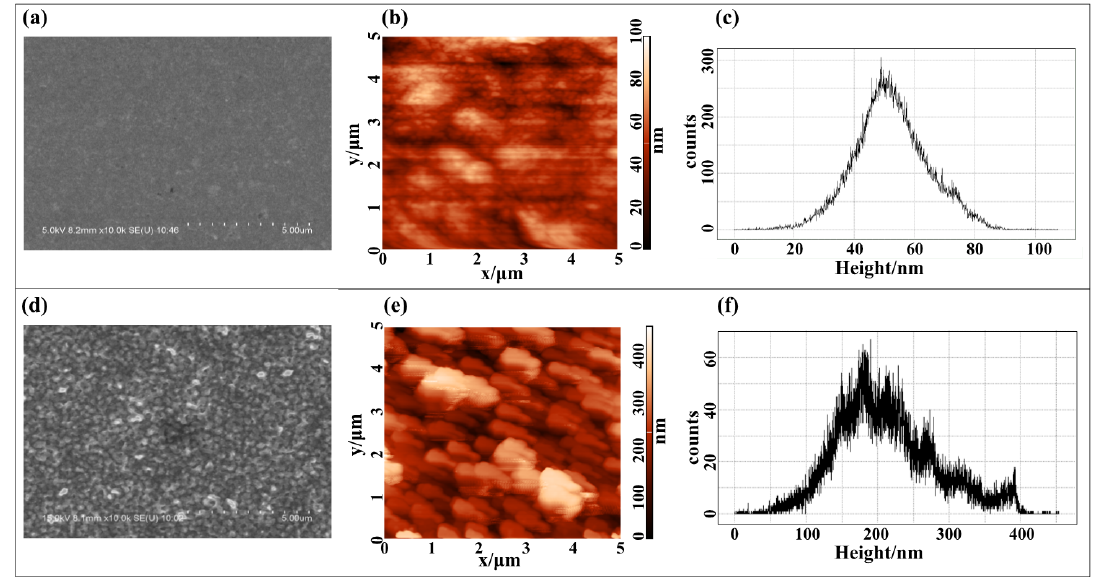
Figure 2. The surface of the electrode before and after etching without protective layer. SEM images before etching ( a ) and after etching ( d ); AFM images before etching ( b ) and after etching ( e ); The counts of the height of the sampling point before etching, Ra = 9.6 nm ( c ) and after etching, Ra = 54.9 nm ( f